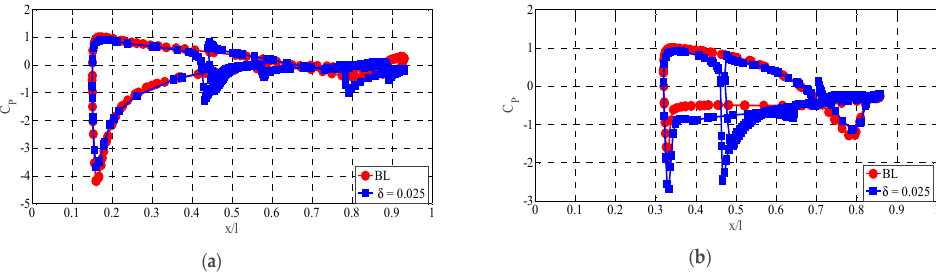
Figure 7. Pressure coefficient C p at ( a ) α = 40 ◦ and ( b ) α = 60 ◦ for δ = 0.025 and x/l chosen as the length of the